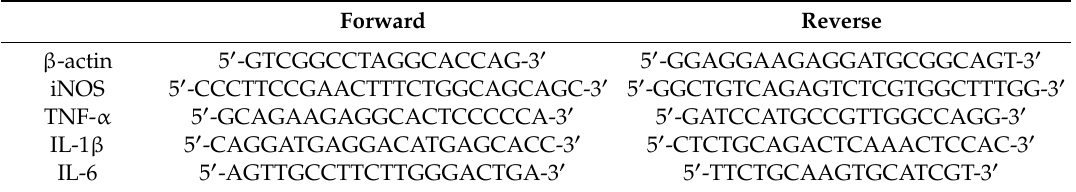
Table 3. Primer sequence of genes used for a reverse transcription-polymerase chain